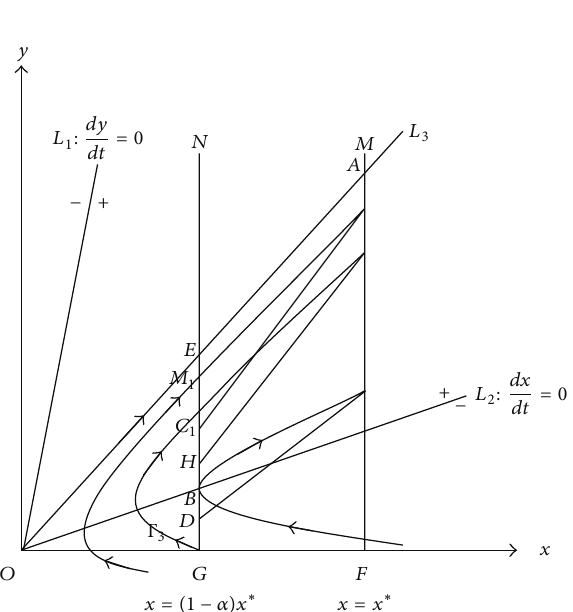
Figure 5: The existence of order-1 periodic solution of system (1) in the domain Δ𝑂𝐹𝐴 when 𝐷 𝑦 < 𝐵 𝑦